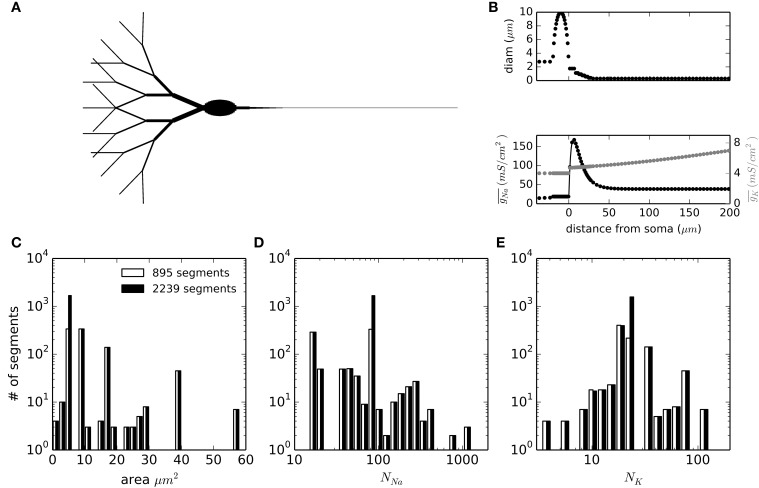
Geometry and compartment statistics of the multicompartment model. (A) Schematic representation of the neuron simulated. The image is not to scale, and longer sections have been shortened for illustration purposes (specially the axon). Total soma length is 20 μm and its widest diameter is 10 μm. Dendrite tips are 300 μm from the soma and the total axon length is 1500 μm (895 segments) or 7500 μm (2239 segments). (B) Diameter of sections and density of sodium and potassium conductance as a function of the distance from the beginning of the axon (negative distances correspond to the soma and dendrites). (C–E) Distribution histograms for the membrane areas (C), the number of sodium channels (D) and the number of potassium channels (E) along the segments (compartments) in which the model is discretized.